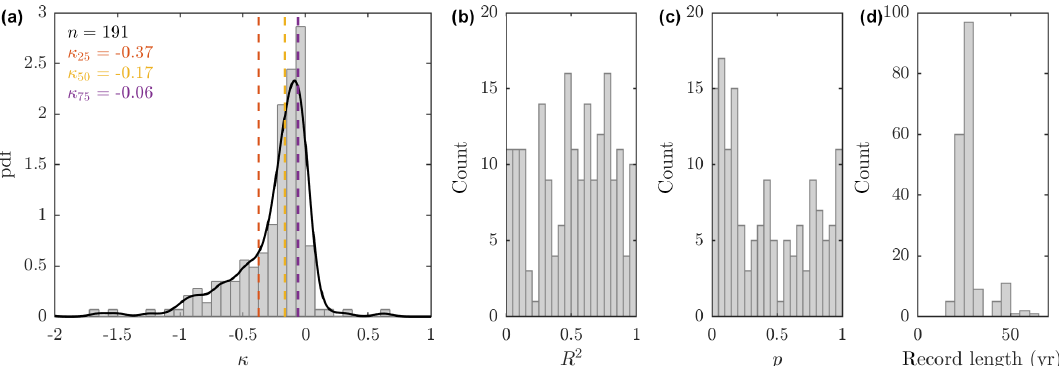
Figure 5. Result of linear regression (as in Fig. 4e and j) for all glaciers. Histograms of (a) sensitivity coefficient κ , (b) correlation coefficient R 2 , (c) statistical significance p and (d) length of record entering the regression. Vertical dashed lines on (a) indicate the quartiles of the distribution, while the solid black line shows a kernel distribution fit to the histogram. Glaciers with a record of length less than 15 years were excluded from all